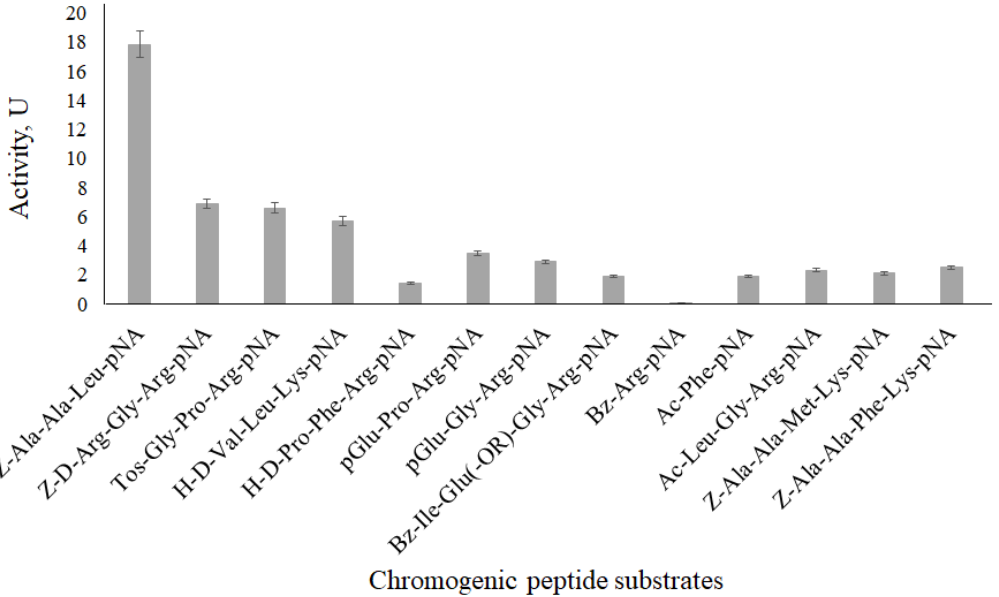
Figure 8. Substrate specificity of the extracellular keratinase synthesized by Aspergillus clavatus VKPM F-1593.